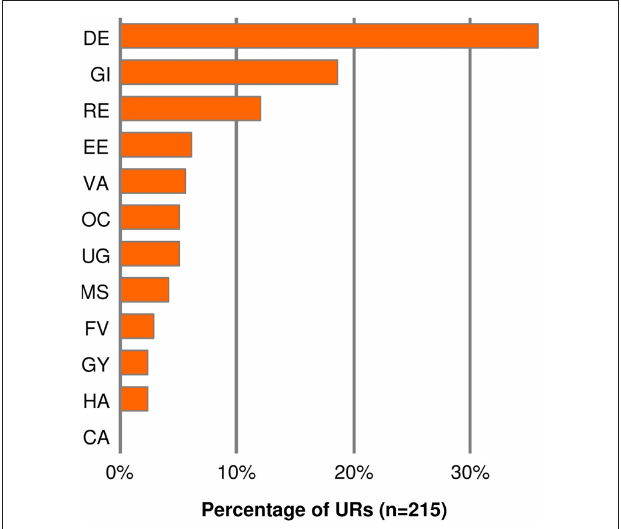
FiguRE 2 | Distribution of the use reports (uRs) of records referring to resins and gums over the 12 medicinal use groups [key to the abbreviations see Quantification and Categorization of the use Reports into use groups (Steps 5 and 6)].